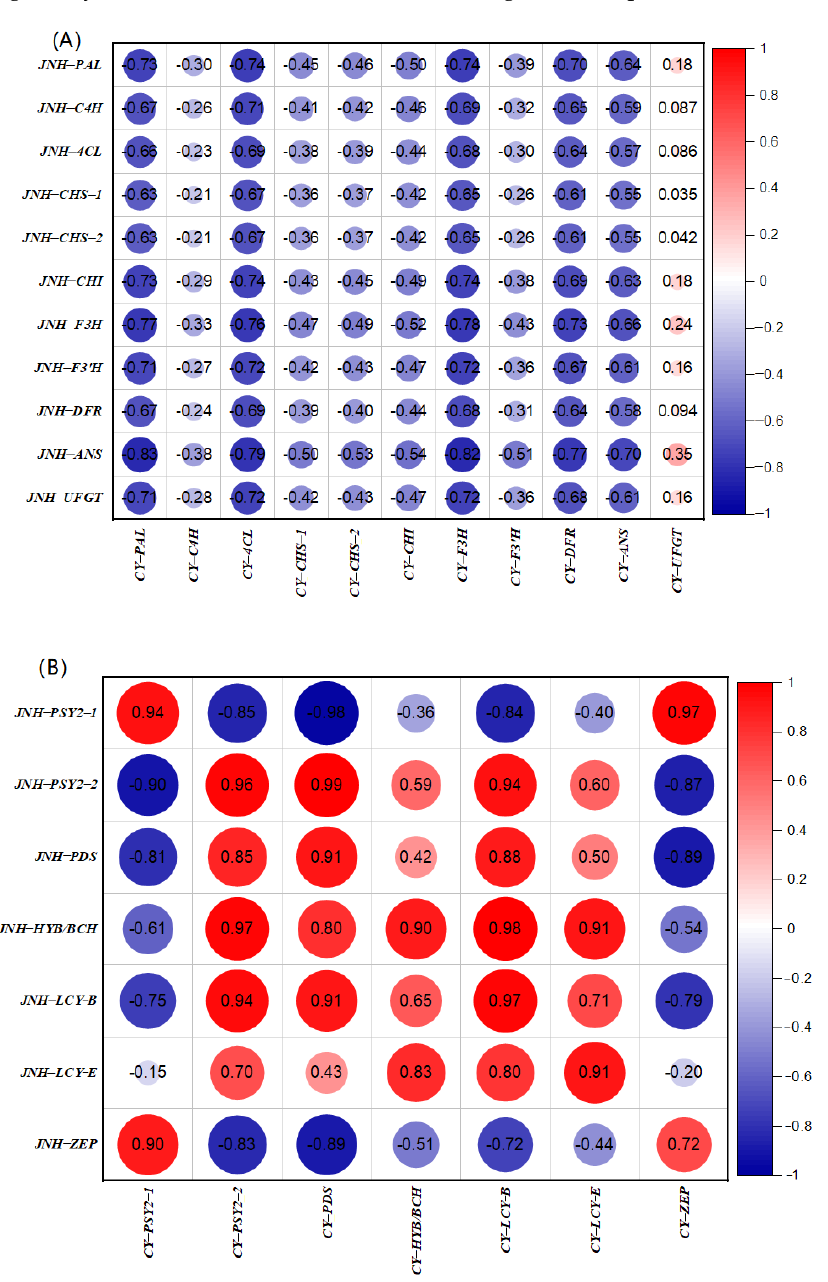
Figure 4. Correlation analysis of anthocyanin ( A ) and carotenoid ( B ) genes between JNH and CY fruits from the RNA-seq data. Red indicates positive correlation and blue indicates negative correlation ( p < 0.05 ).